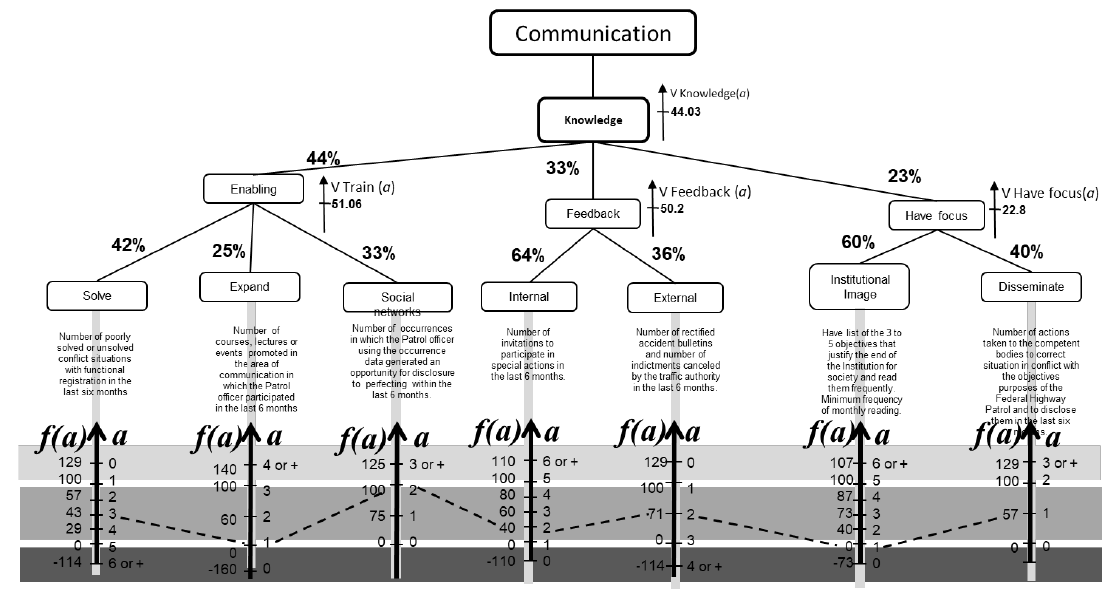
Figure 4. Application of the Roberts Matrix and MACBETH Method to determine compensa- tion rates.